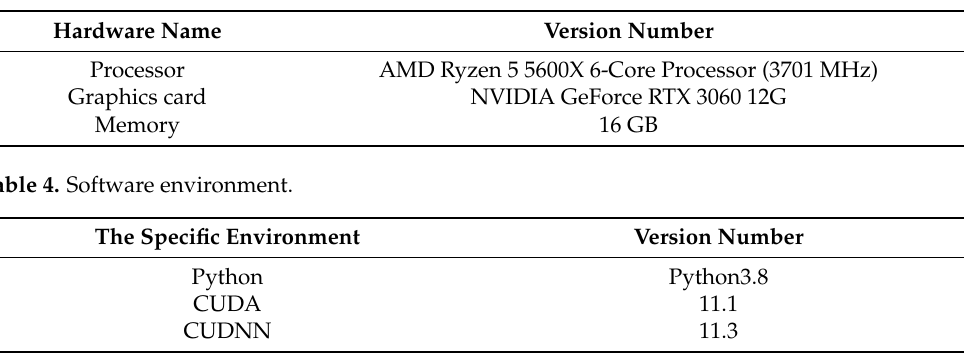
Table 3. The development environment.